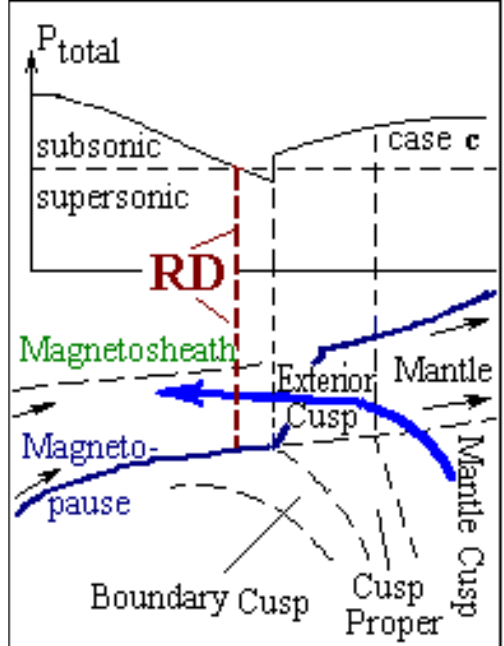
Fig. 1. Yamauchi and Lundin (1997) “Laval nozzle” model sketch; thick arrow infers Interball-1 orbit (see Plate A2). See text for fur- ther